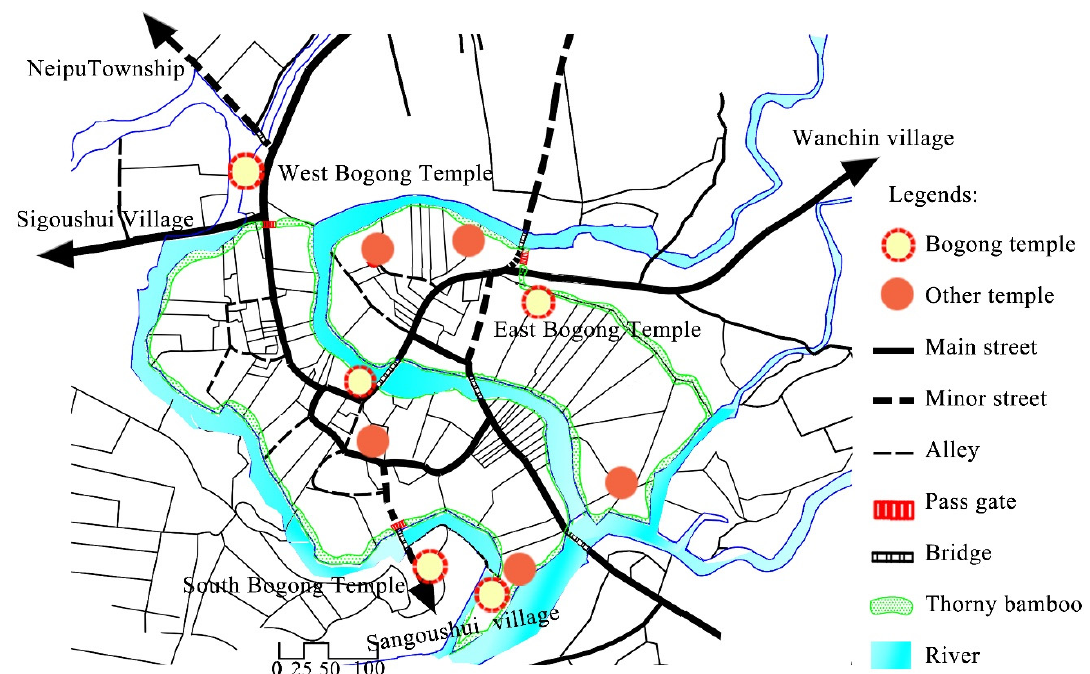
Figure 3. Wugoushui settlement before 1895.